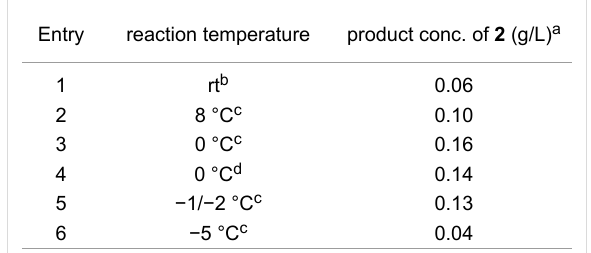
Table 2: Enzymatic hydroxylation of n